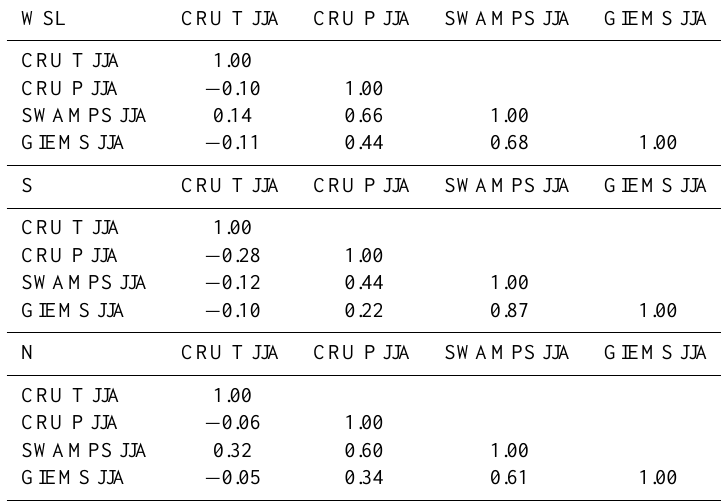
Table 8. Temporal correlations among environmental drivers, 1993–2004.